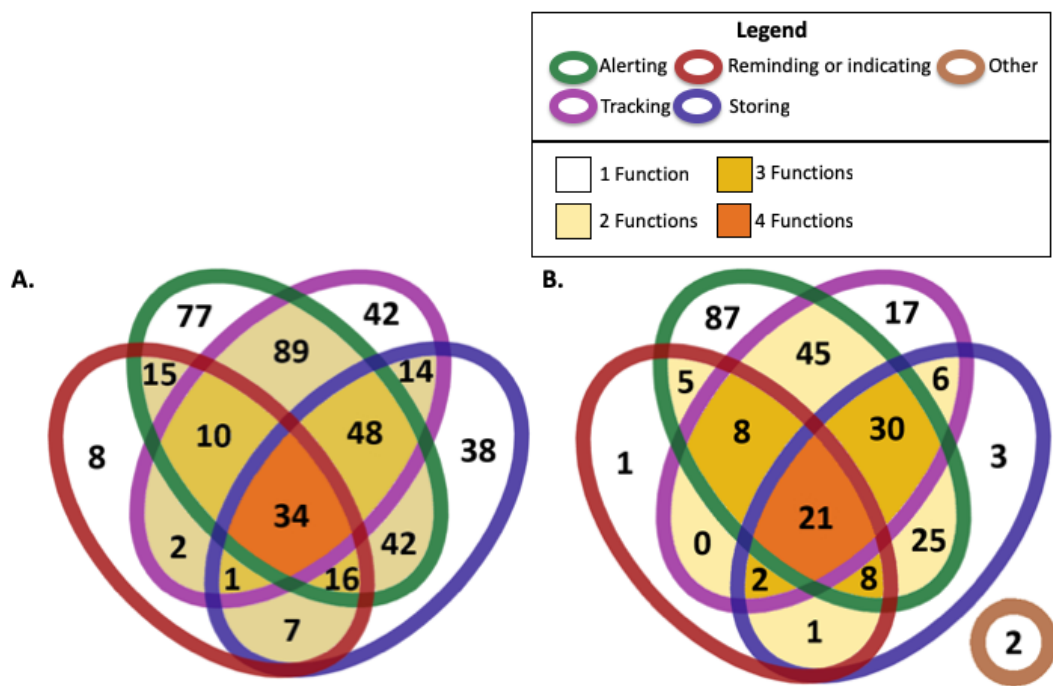
Figure 2. Smartphone medication adherence apps according to 4 key features: alerting (to take medication), tracking (medication taking), reminding (to refill)/indicating (amount of medication left) and storing (medication information) for A. Apple and B. Android operating